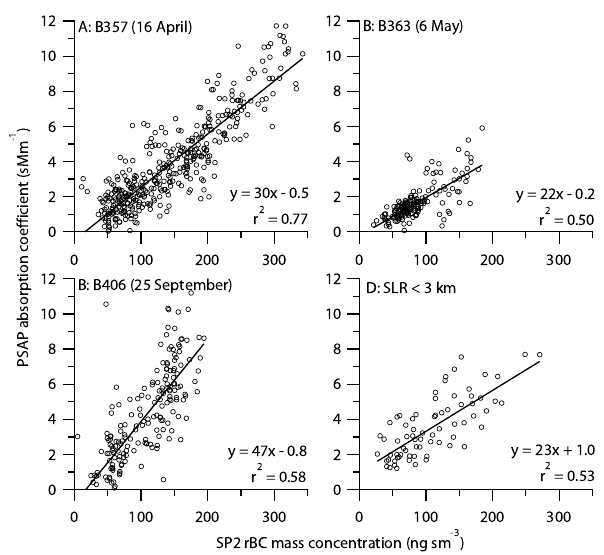
Fig. 6. Scatter plots comparing FAAM research aircraft PSAP- measured aerosol light absorption coefficients to SP2-measured refractory black carbon mass concentrations for three individual flights during the (a) April, (b) May and (c) September portions of the campaign and (d) for all straight and level averages below 3km altitude. The linear least-square regression of the PSAP data to the SP2 refractory black carbon concentration measurements and square of the Pearson correlation coefficient ( r 2 ) are also shown for each case.